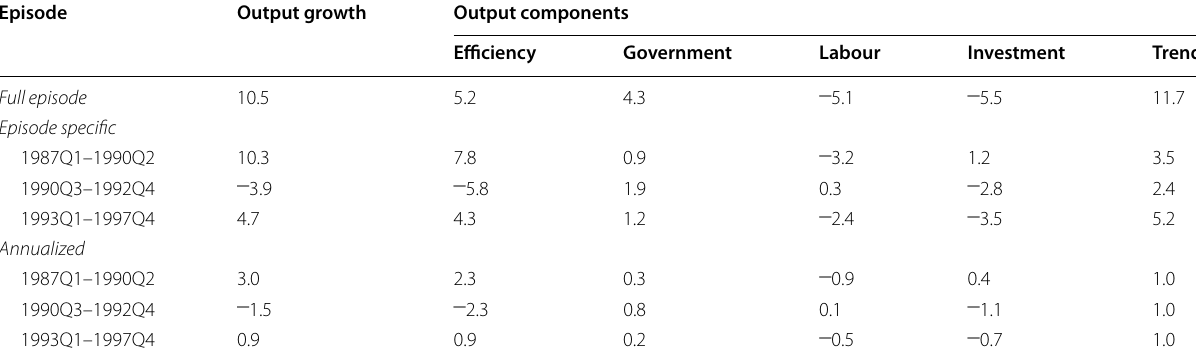
Numbers in per cent. Output growth measured in real per capita terms